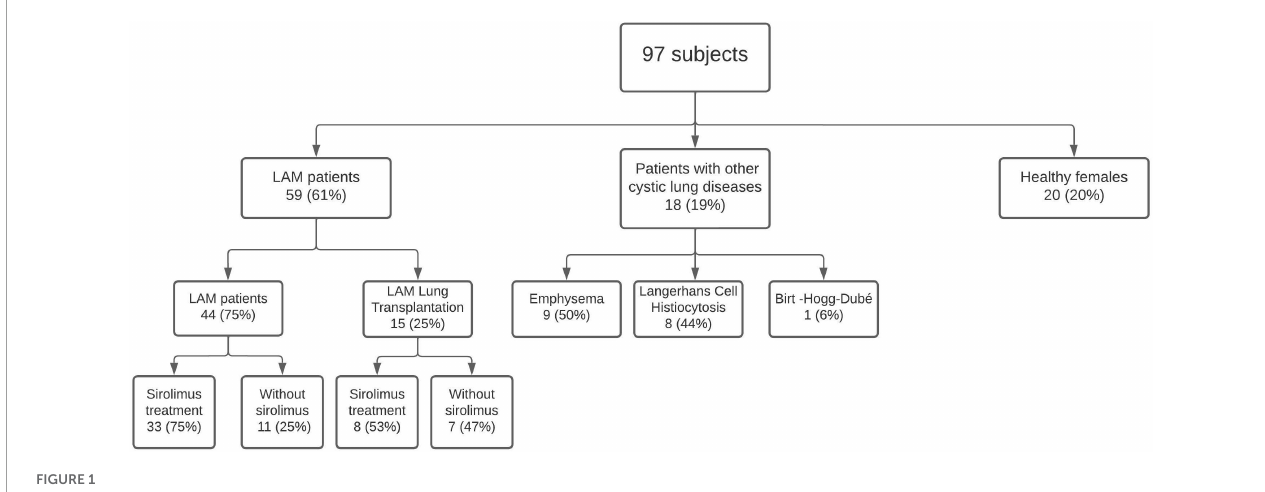
FIGURE1 Subjects enrolled in the study.